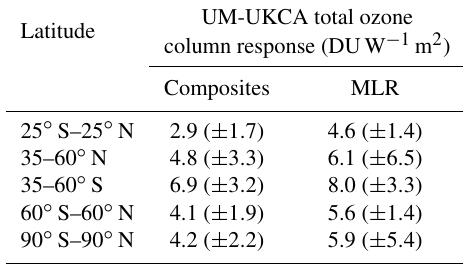
Table 2. Yearly mean total ozone column response (DUW − 1 m 2 ), ± 2 standard errors, in UM-UKCA derived using composites and